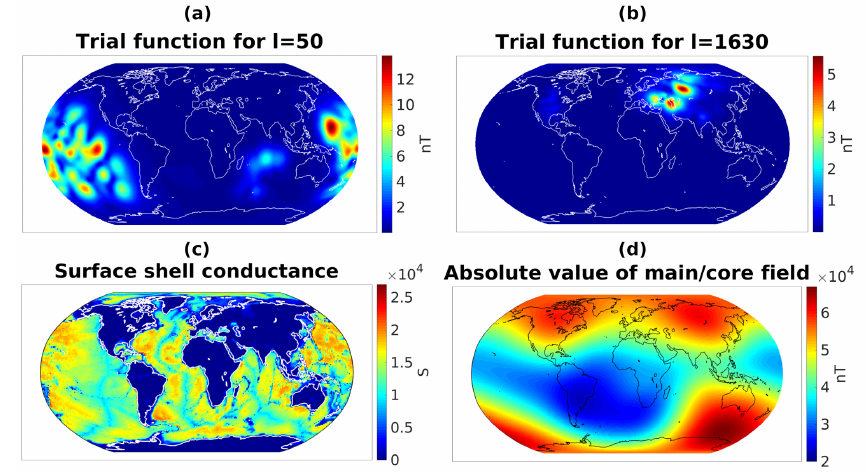
Figure 3. Absolute value of the trial function B re u = g ( 3 ) at time t = 0 (b) . Models of surface shell conductance on S a and absolute value of B main on S a used for the generation of the 1630 trial functions (c, d) .